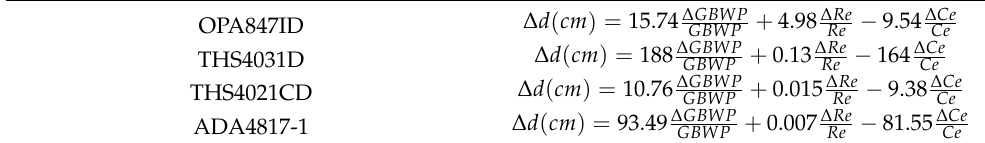
Table 3. Contributions to distance stability due to different OAs according to Equation (14). Cf